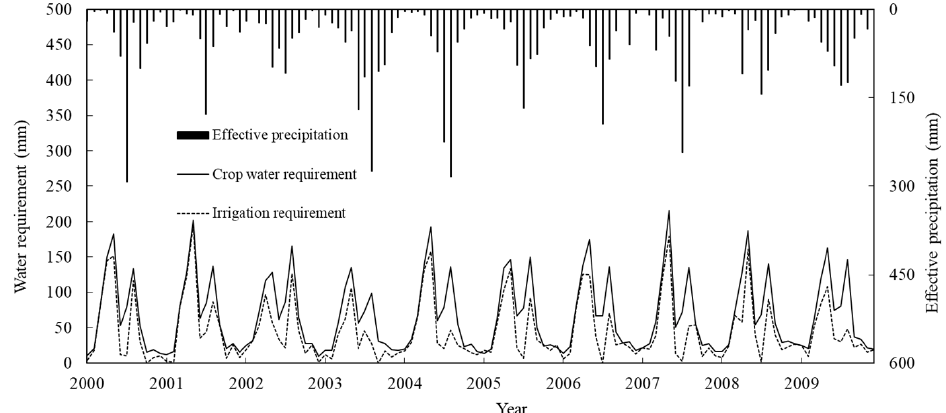
Figure 6. Annual effective precipitation, crop water demand, and irrigation demand.